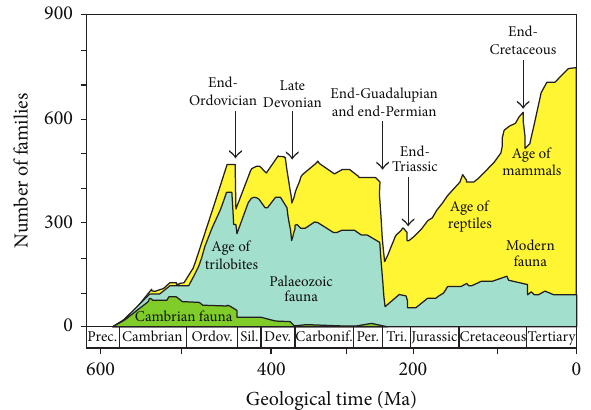
Figure 5: Number of families as a function of geologic time, show- ing the five major extinction events marked by sharp biodiversity decrease (adapted from Raup and Sepkoski